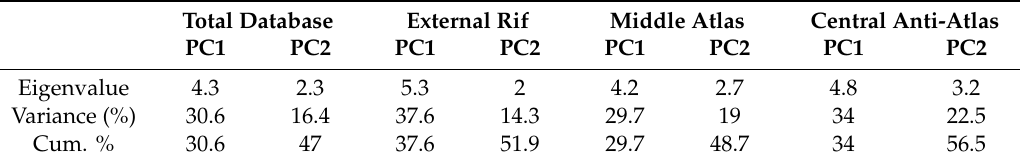
Table 2. Eigenvalues and percentage of explained variance by the first and second principal components for the total database and the three sectors.